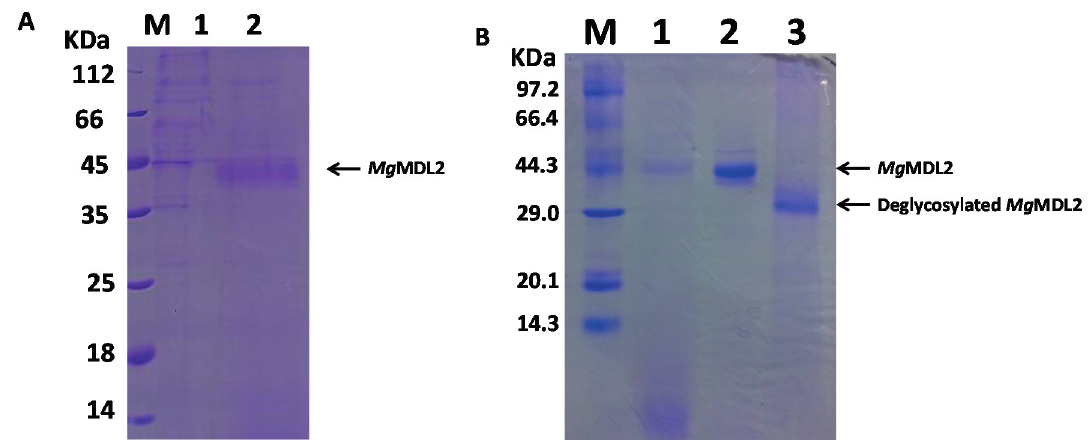
Figure 2. SDS-PAGE analysis of purification and deglycosylation of Mg MDL2. ( A ) Detection of expression of Mg MDL2. Lane M: marker; Lane 1: Supernatants of control P. pastoris X-33; Lane 2: Supernatants of recombinant P. pastoris X-33 having pGAPZ α A- mgmdl2 ; ( B ) Purification and deglycosylation of Mg MDL2. Lane 1: Supernatant of fermentation